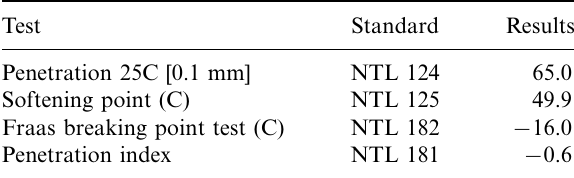
Table 1. Specific properties of bitumen Test Standard